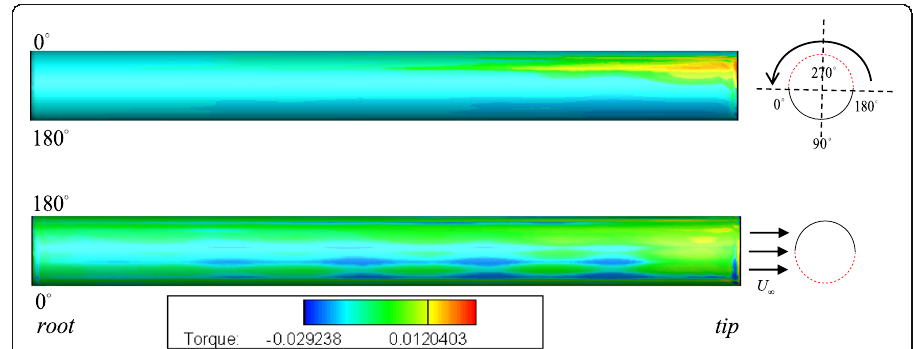
Fig. 7 Distribution of torque on the Magnus blade with AR = 10. The projected surface is denoted by the black solid